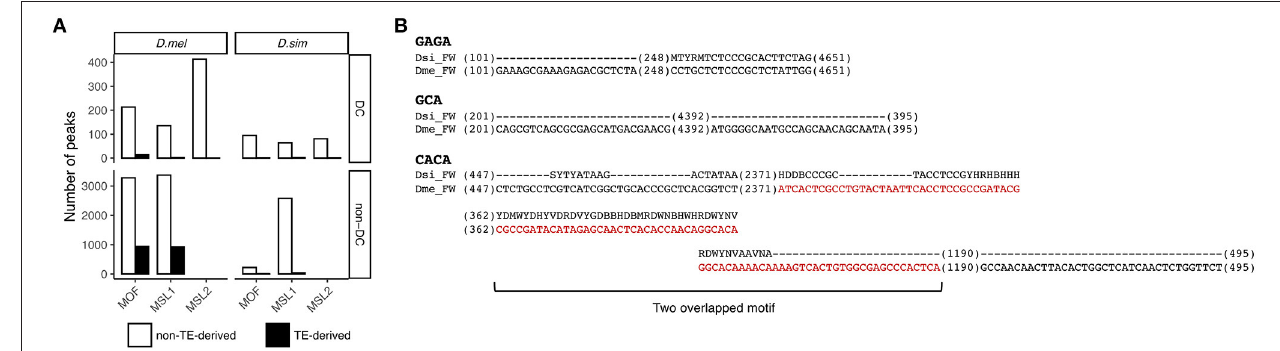
FIGURE 4 | Contribution of TEs to non-DC sites. (A) Numbers of DC and non-DC sites located in or outside of TEs in D. melanogaster ( D. mel ) and D. simulans ( D. sim). (B) FW transposon family provides MSL binding motifs in D. melanogaster but not in D. simulans . Sequences alignments show GAGA, GCA, and CACA motifs in the consensus sequences of the FW family in D. melanogaster and D. simulans . Sequences in red are in MSL1 non-DC binding